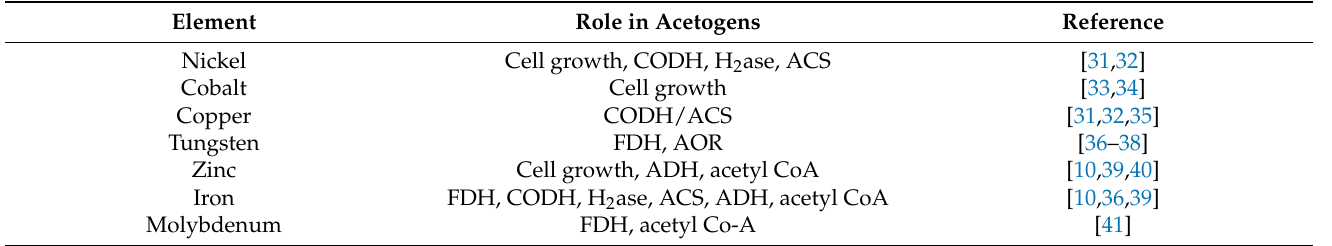
Table 6. The functions and roles of the trace metals in